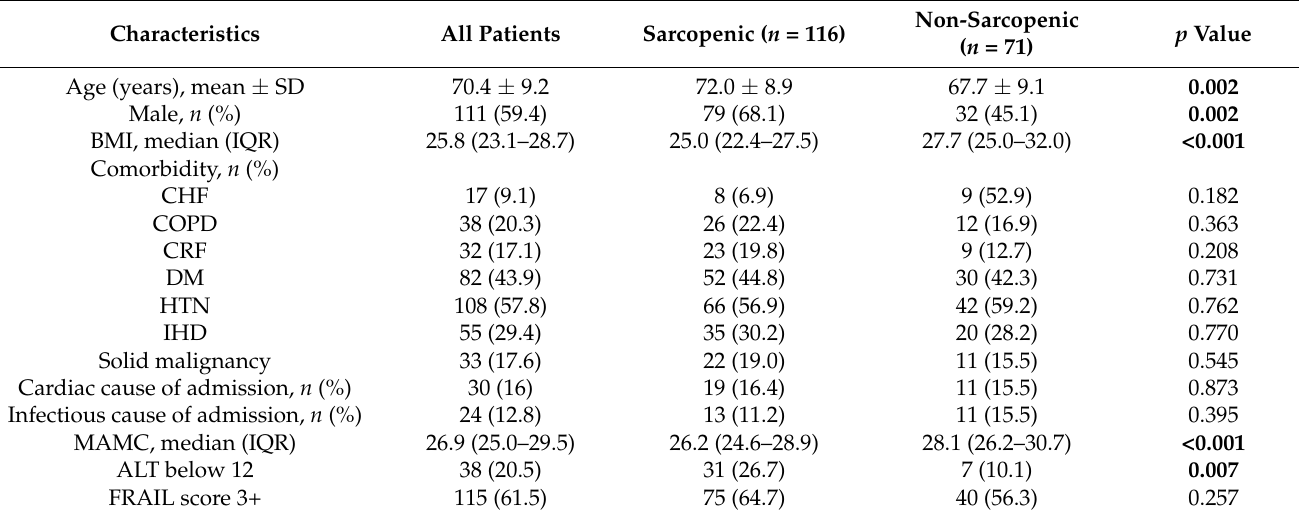
Table 1. Patients’